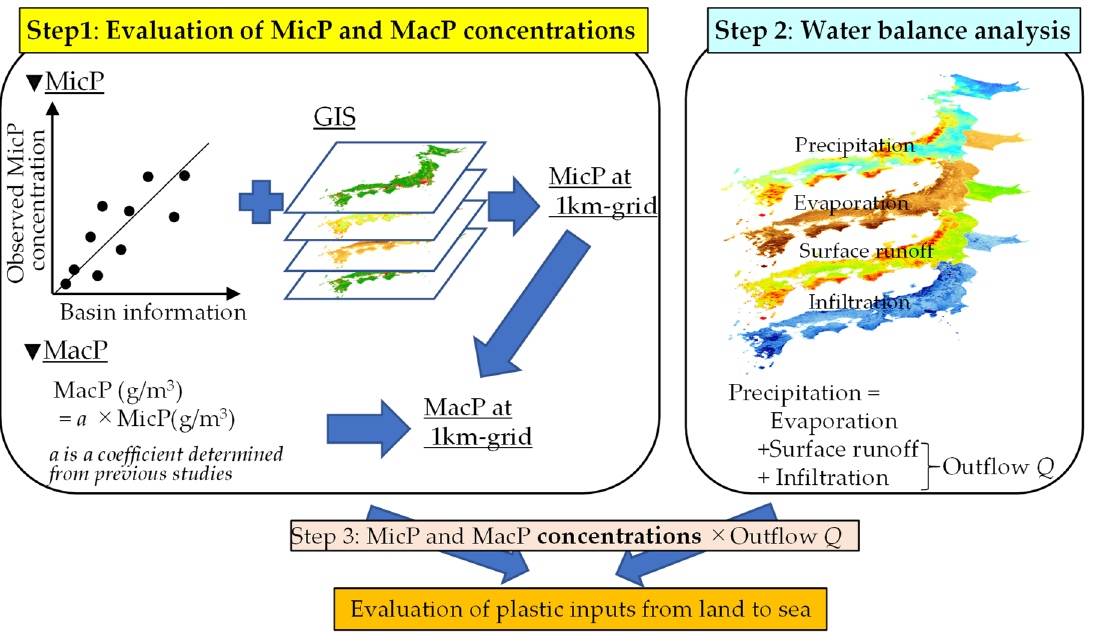
Figure 1. Schematic of the conceptual framework used to evaluate plastic inputs from the land to the sea in this study.